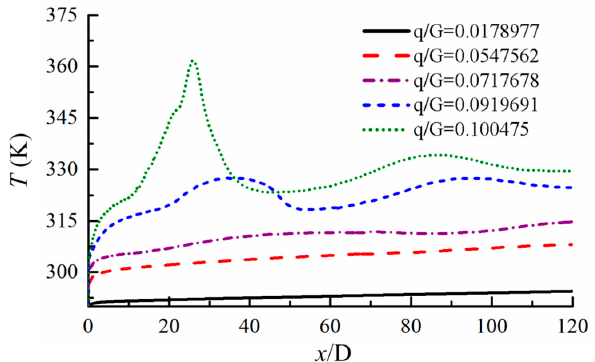
Figure 11. Temperature distribution with various heat flux densities.